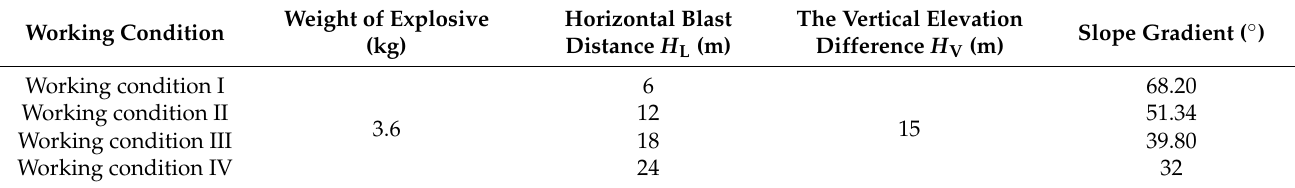
Table 4. The detailed data of four working conditions.